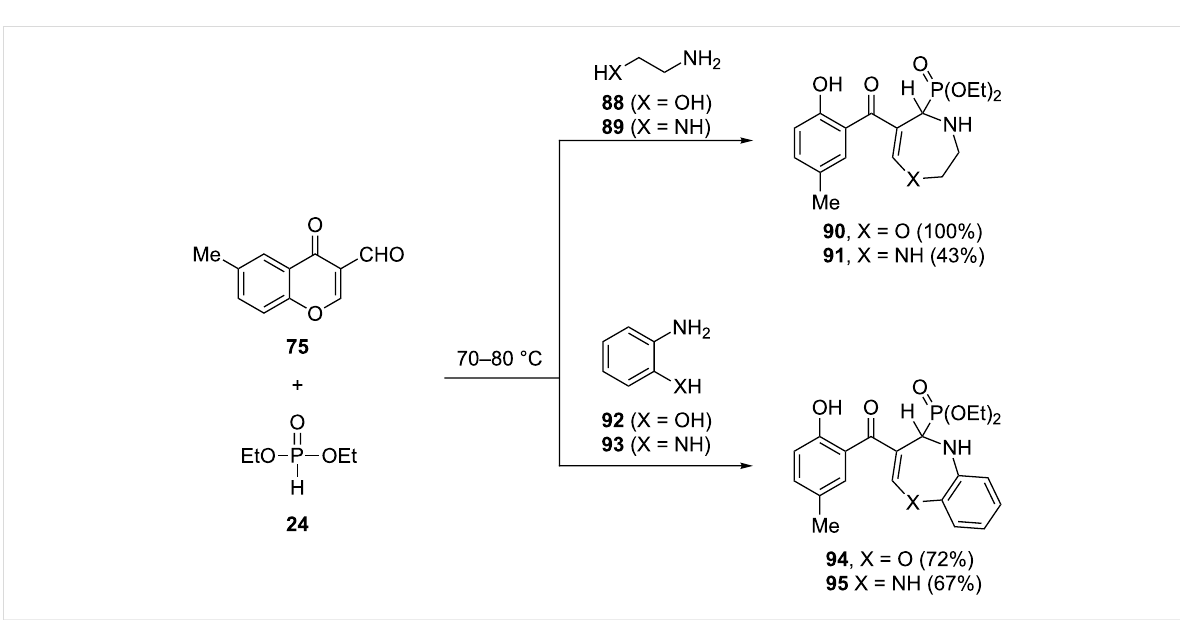
Scheme 21: Three-component reaction of 6-methyl-3-formylchromone ( 75 ) with 1,4-bi-nucleophiles in the presence of diethyl phosphonate.